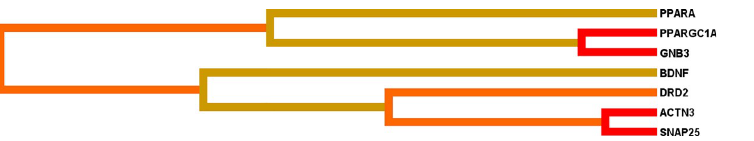
Fig 1. A gene-gene interaction dendrogram in sports gymnastics performance a . a Orange line indicates weak positive interaction between clusters. Golden connections suggest the independence of PPAR α , BDNF .